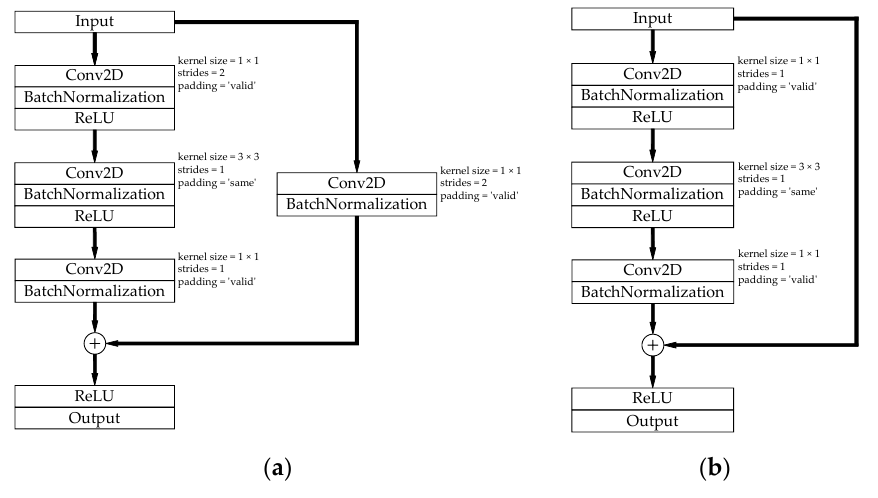
Figure 3. ( a ) Conv Block; ( b ) Identity